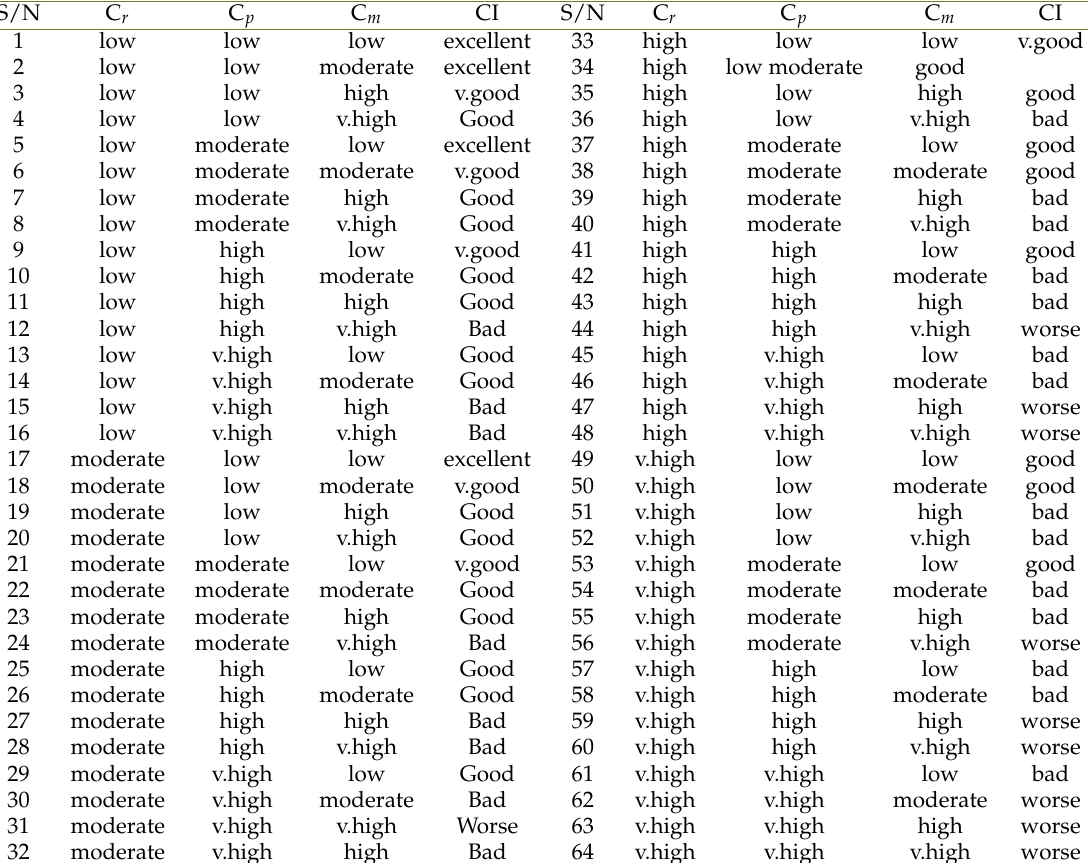
Table 3. Rules base for membership functions interaction